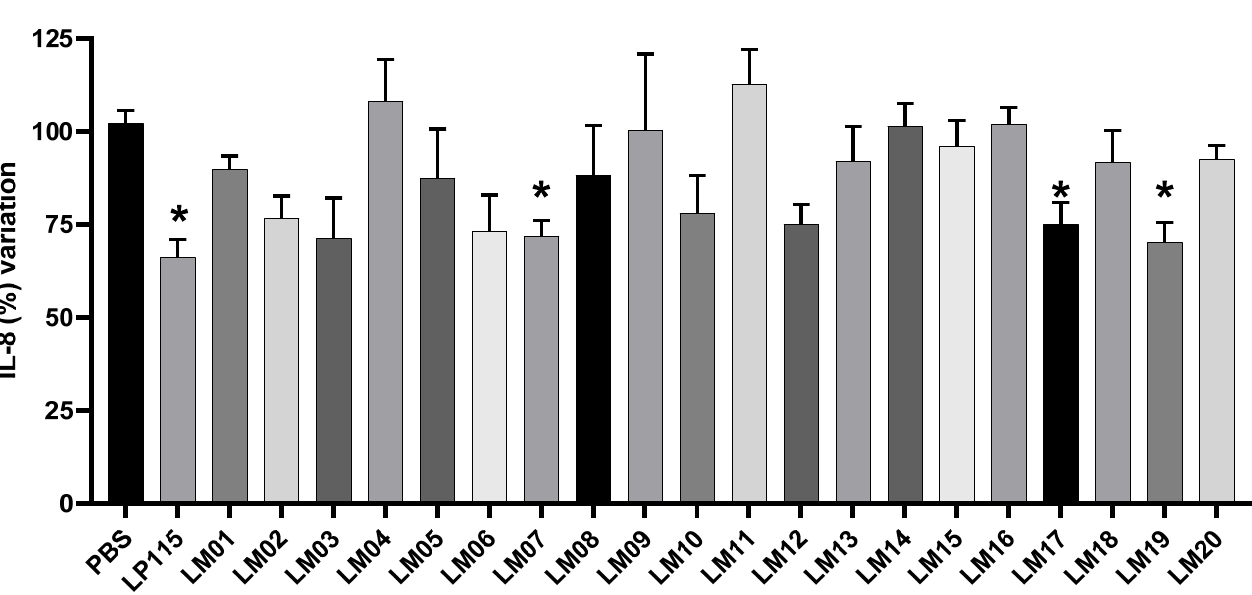
Figure 4. Effect of LAB isolated from agave samples on IL-8 production on HT-29 cells. Results are presented as means ± SEM. * indicates a significant difference as compared to the PBS group ( p < 0.05).